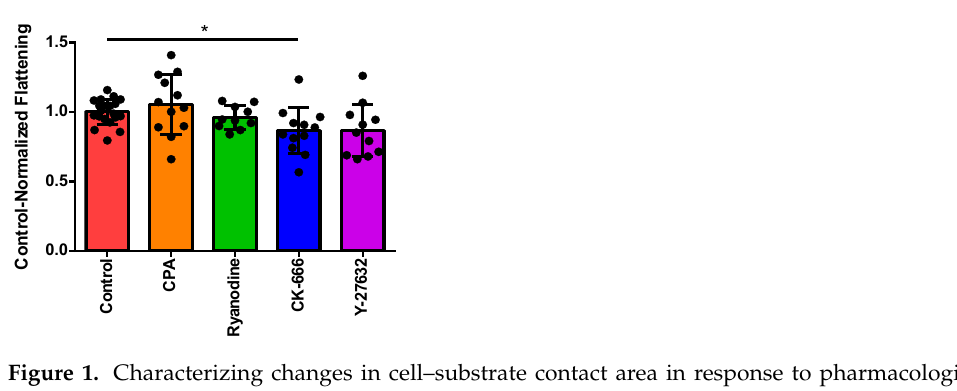
Figure 1. Characterizing changes in cell–substrate contact area in response to pharmacological inhibitors. Each data point represents an individual eosinophil. Control-normalized cell flattening (see Section 2) in cells treated with vehicle (control; n = 20), CPA ( n = 12), ryanodine ( n = 10), CK-666 ( n = 12), or Y-27632 ( n = 11). * p < 0.05 by Kruskal–Wallis test.